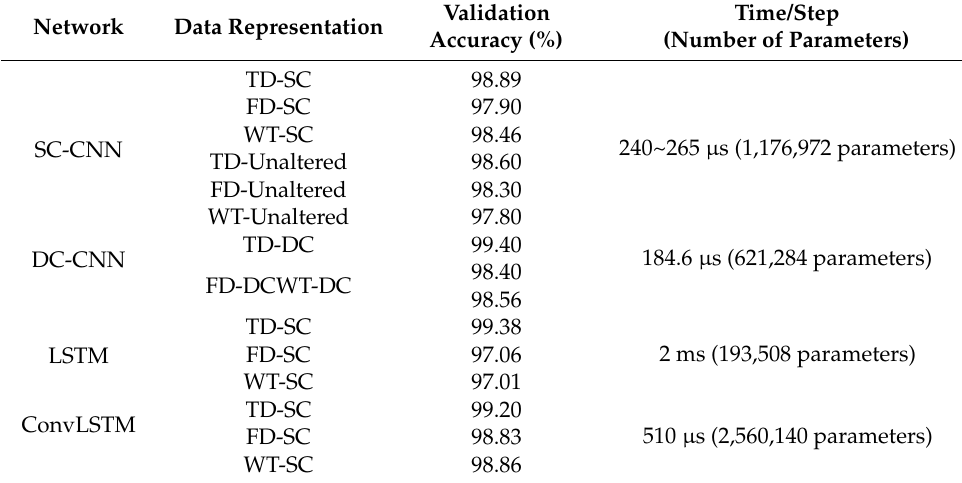
Table 2. Comparison of the models for 100